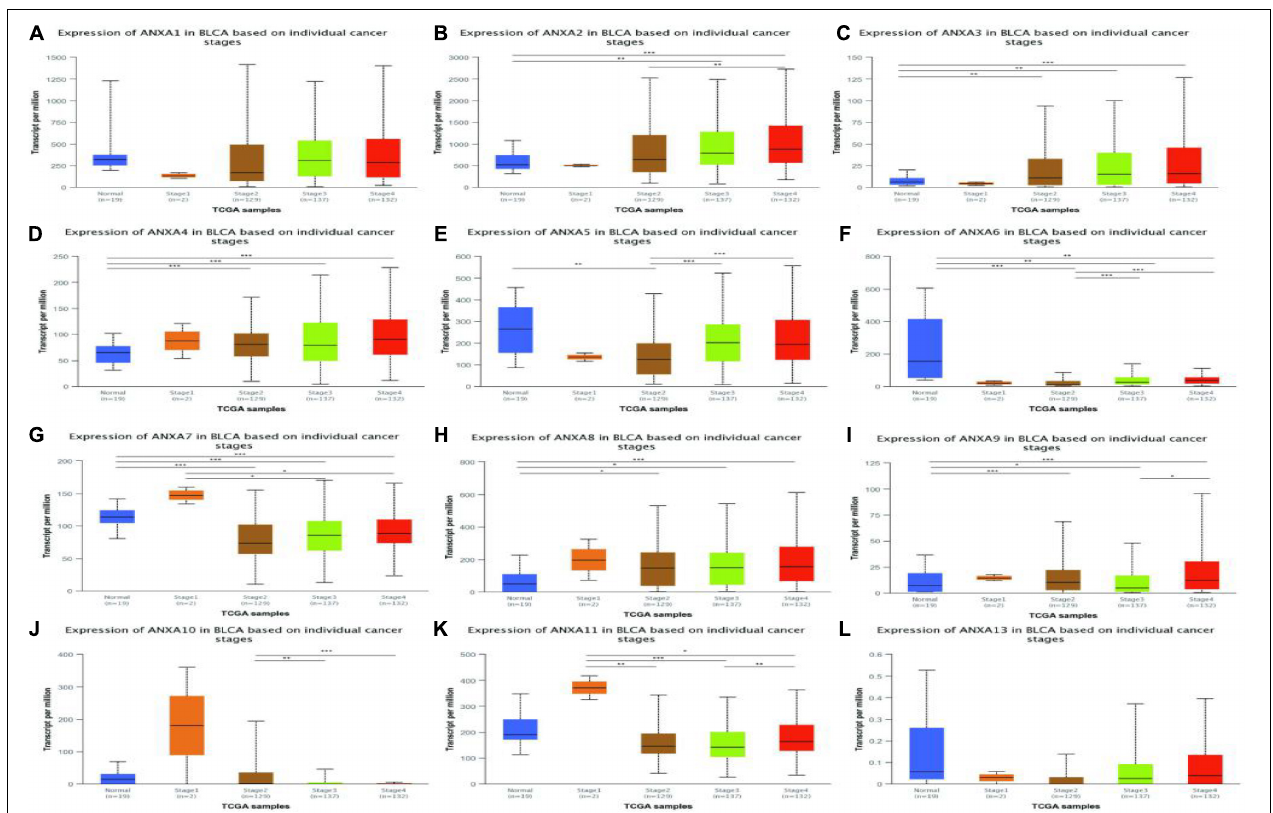
FIGURE 4 | Correlation between the mRNA expression of different ANXA members and the bladder cancer stage of patients in UALCAN database. The mRNA expression of ANXA family members in normal individuals or in BC patients in stages 1, 2, 3 or 4 (A–L) . (* p < 0.05; ** p < 0.01; *** p <